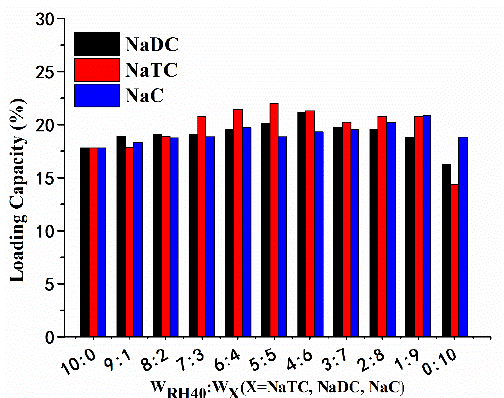
Figure 2. Loading capacities of blank SMEDDS after replacing RH40 using bile salts at different proportions of the mixed surfactants ( n = 3).